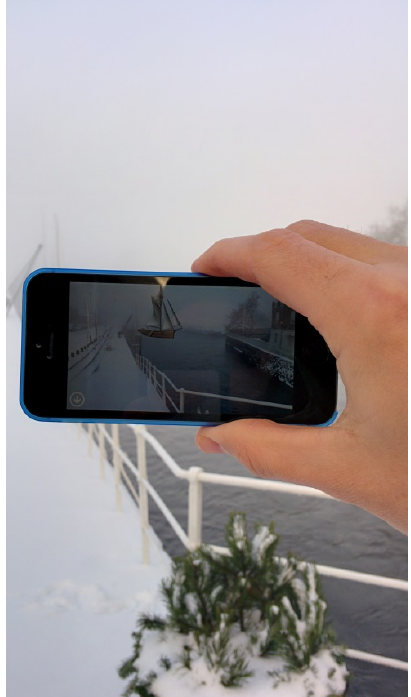
Figure 11. Mobile augmented reality-application bringing ships back to the old harbour. Sydvestjyske Museer, Denmark. Photo: The author.